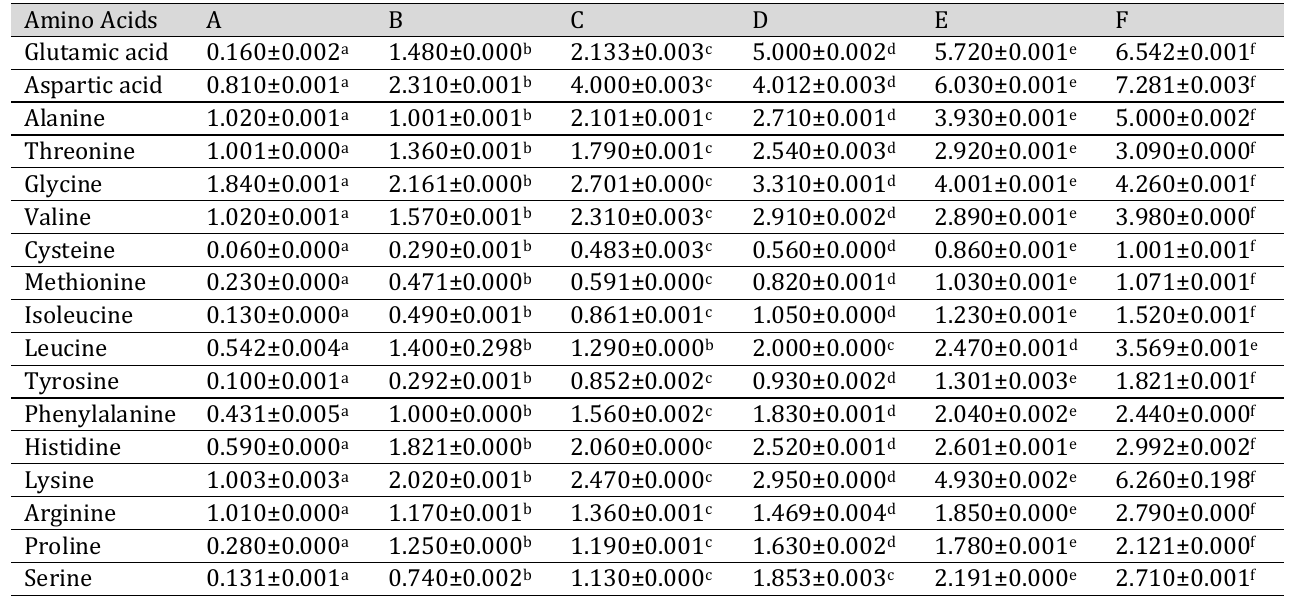
Table 5. Amino acid composition of extruded blends of Cassava-African yam bean (g/100g).